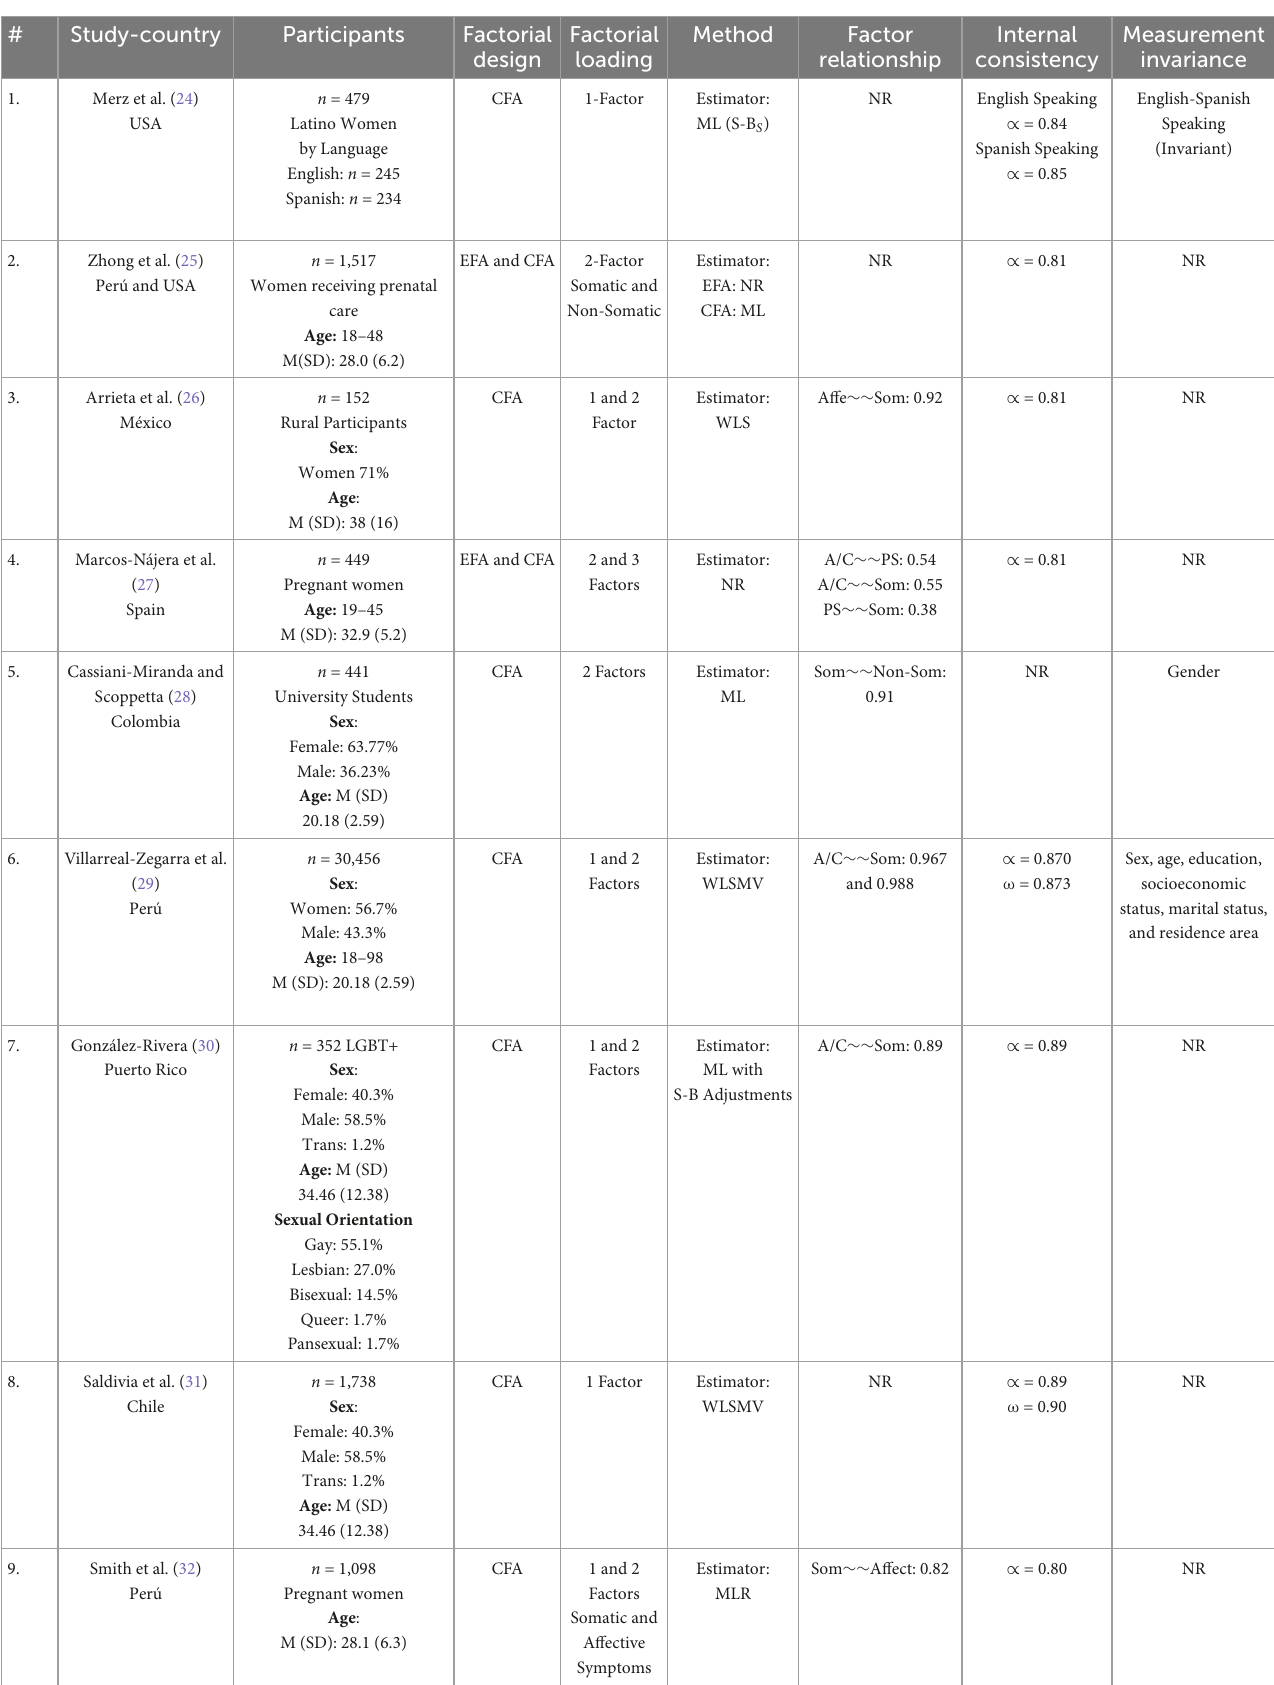
TABLE 1 Brief systematic review of the PHQ-9 Spanish